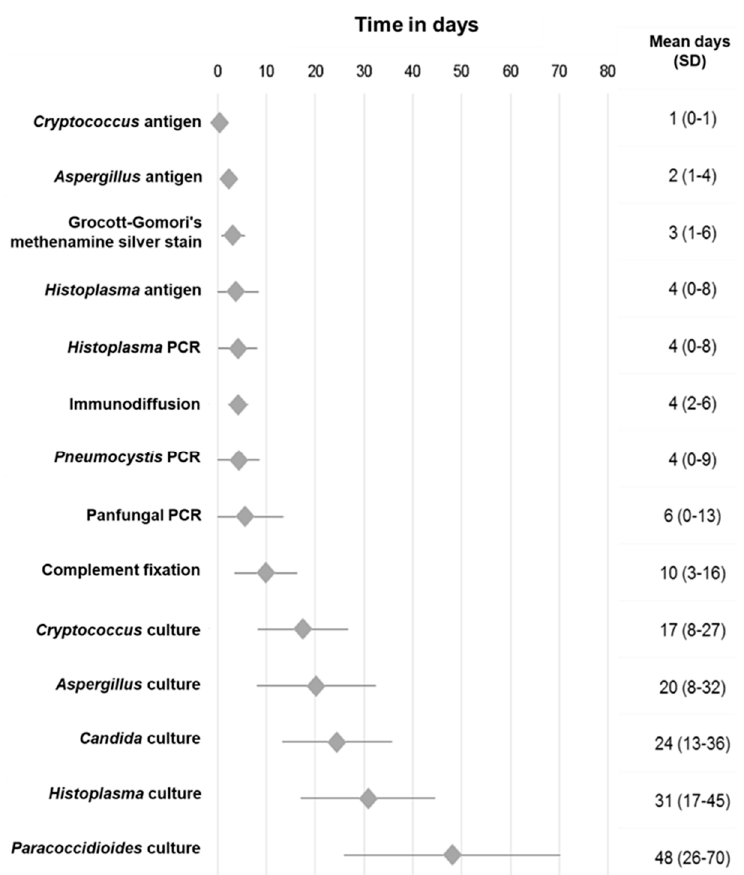
Figure 2. Analysis of result turnaround time, according to laboratory methods used in the diagnosis of Invasive fungal diseases.